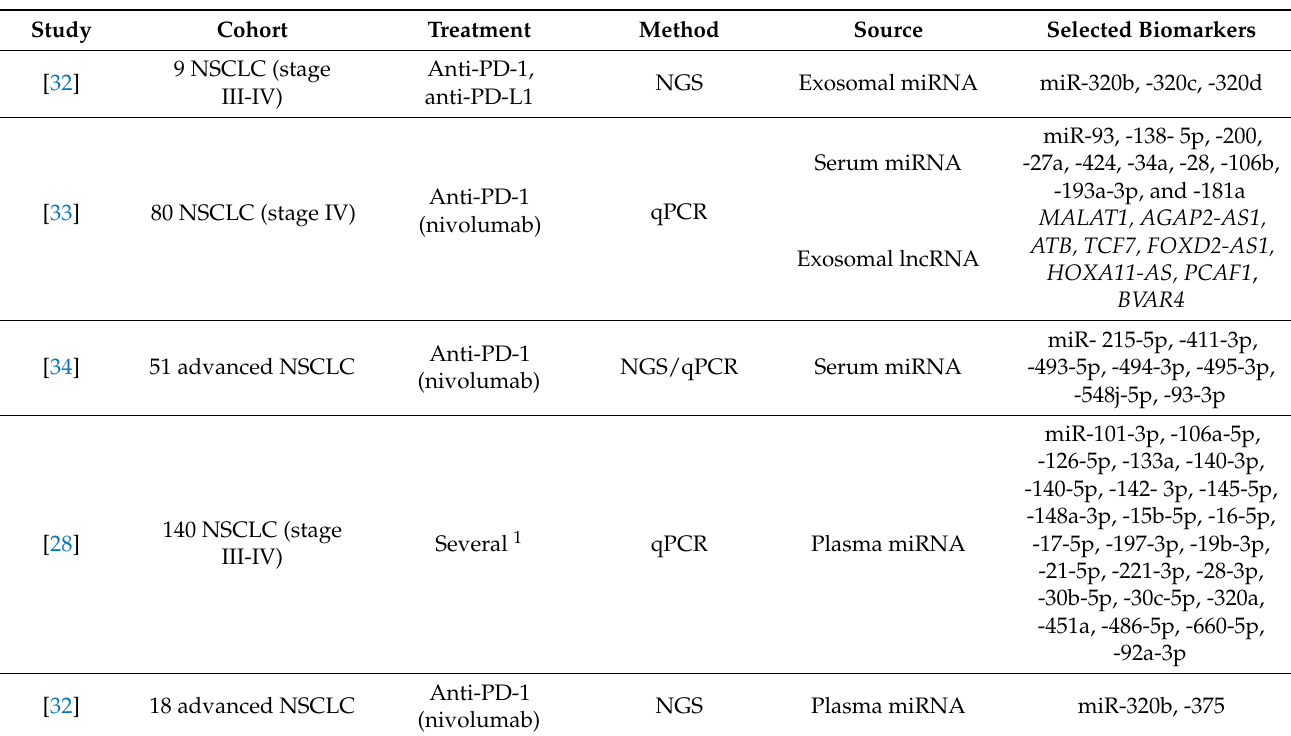
Table 1. Circulating ncRNA identities identified as potential biomarkers for ICI response prediction in